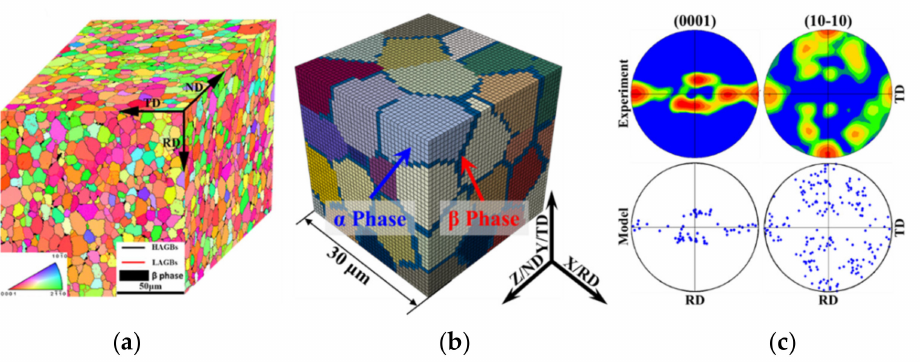
Figure 2. Microstructure characterisation and polycrystalline model of the undeformed near- α TA15 sheet. ( a ) Inverse pole figures [11,20]; ( b ) polycrystalline model; ( c ) comparison of grain orientations in experiment and